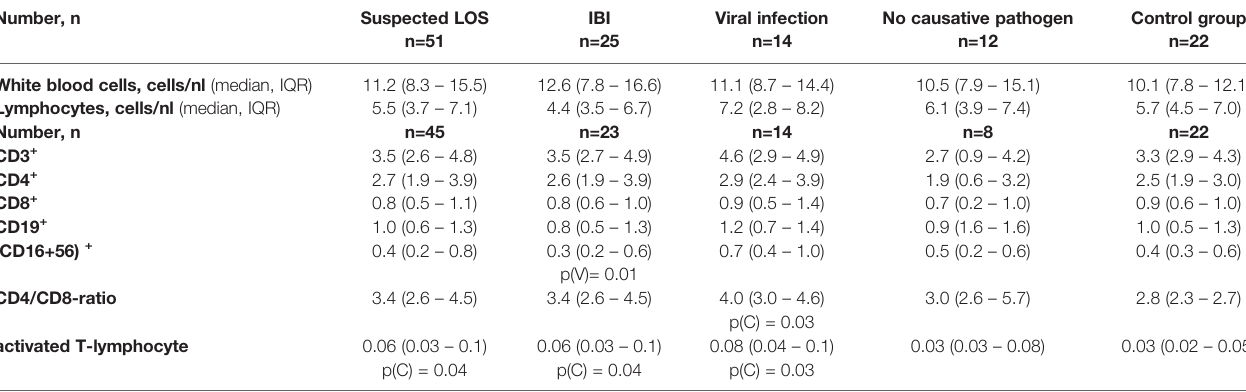
FIGURE 5 | Frequencies of regulatory T cells strati fi ed to infants ’ age and subgroups of study cohort. Boxes are shown as median and IQR; whiskers show minimum and maximum values; *p-values were derived from Dunn ’ s multiple comparisons test (<0.05). TABLE 4 | Lymphocyte subsets and immune cell count of study cohort and subgroups. Number,